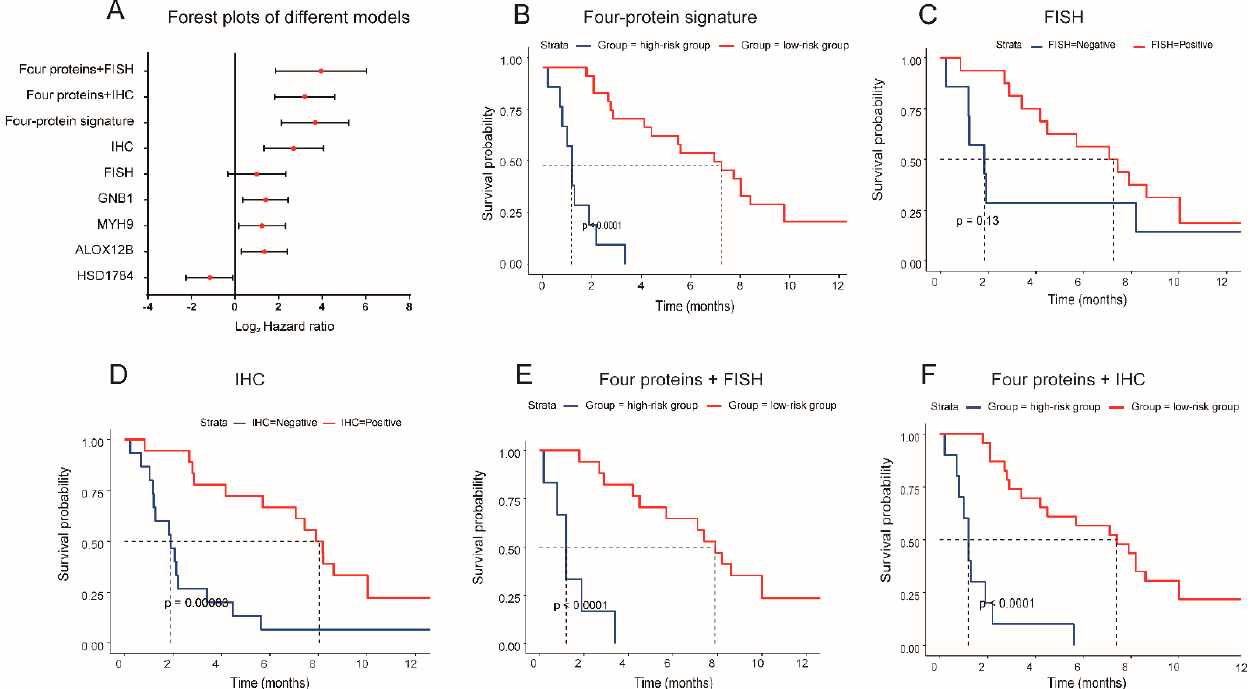
Figure 4. The predictive performance of different models for progression-free survival of patients treated with MET inhibitors. ( A ) Forest plots of hazard ratios and 95% confidence interval in different predictive models. Kaplan–Meier plots of progression-free survival based on the combination of four proteins ( B ), MET FISH ( C ), MET IHC ( D ), Four proteins plus FISH ( E ), and four proteins + IHC ( F ).